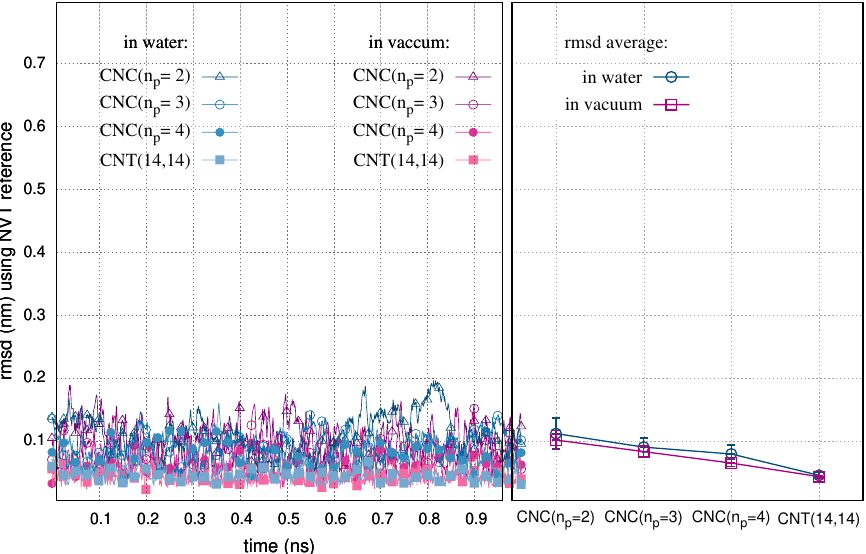
Figure 3. Root mean squared displacement (rmsd) of CNT(14,14) and CNCs with different number of pentagons, n p , at the tip. The trajectories correspond to NPT simulations at 1 ns and 300 K. As a reference for the displacements, we use a configuration from a previous NVT equilibration step. We consider the nanoparticles embedded in water (blue) or vacuum (purple). Right panel: The average rmsd and the standard